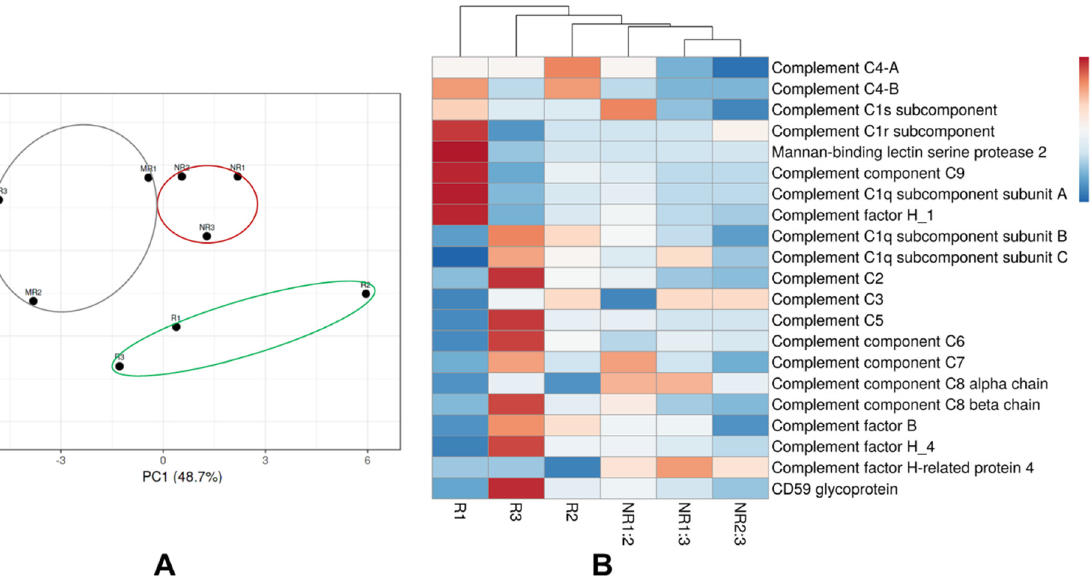
Figure 7. Complement associated extracellular vesical proteins were able to discriminate the responder from the non- responder regardless of time assayed. ( A ) Unit variance scaling and SVD with imputation was used to calculate principal components. X and Y axis show principal component 1 and principal component 2 that explain 48.7% and 21.7% of the total variance, respectively. ( B ) Euclidean clustering distance and Ward clustering method were used to generate the heatmap. Temporal samples from the responder (green) or the non-responder (red) grouped closely with each other.